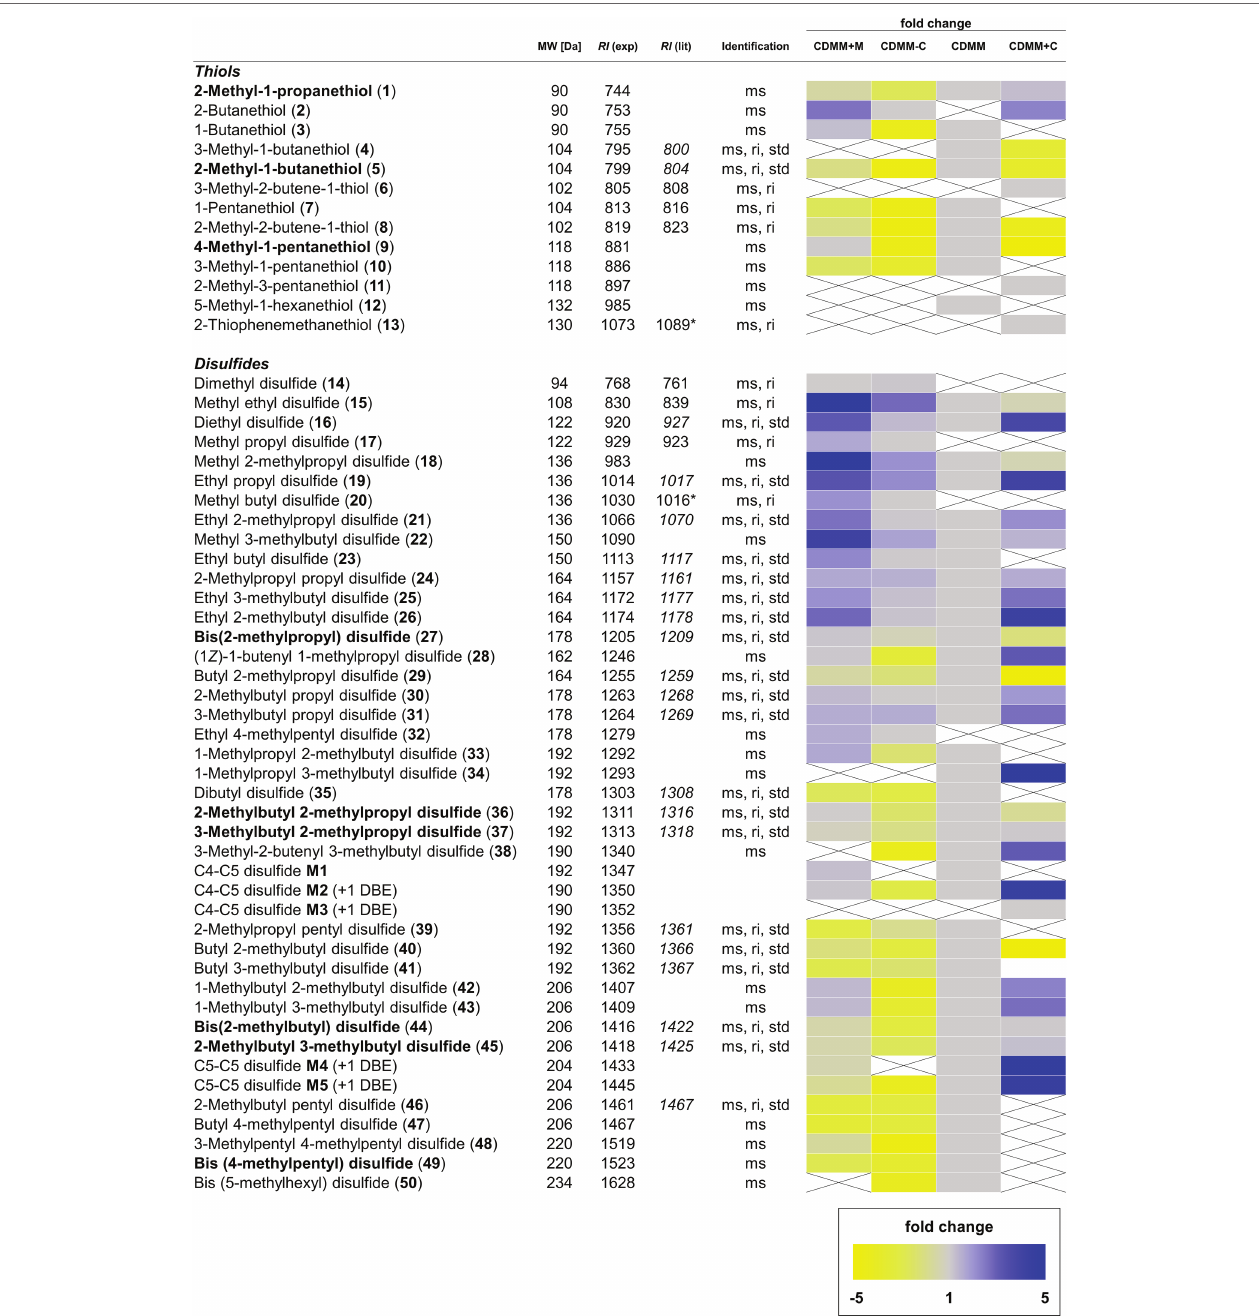
FIGURE 3 | Overview of volatile thiols and disulfides found in Clostridioides difficile 630 Δ erm . Compounds annotated in bold are major components of the volatile bouquet. The molecular weight (MW) is given in Da. Compound identification was based on comparison of spectra with those of data bases and mass spectrometric fragmentation (ms), comparison of retention index to published values on the same or similar GC phases (ri), as well as comparison to commercially available or synthetic reference compounds (std). Retention indices from our own database are shown in italic. Retention indices determined on a GC phases related to but not identical to the HP5-MS phase used are marked with an asterisk. Fold changes of integrated signals from CDMM+M, CDMM-C, and CDMM+C were referenced to CDMM. When one compound was not found in reference CDMM, the lowest integrated signal detected was used as referencing point. Muted yellow squares represent a decrease fold change of − 1.1 to − 5.0 and bright yellow squares decrease fold changes < − 5.0. Light blue squares represent an increase fold change of 1.1–5.0 and dark blue squares >5.0. Gray squares show fold changes between 0.9 and 1.1. Crossed, white squares represent compounds below the detection